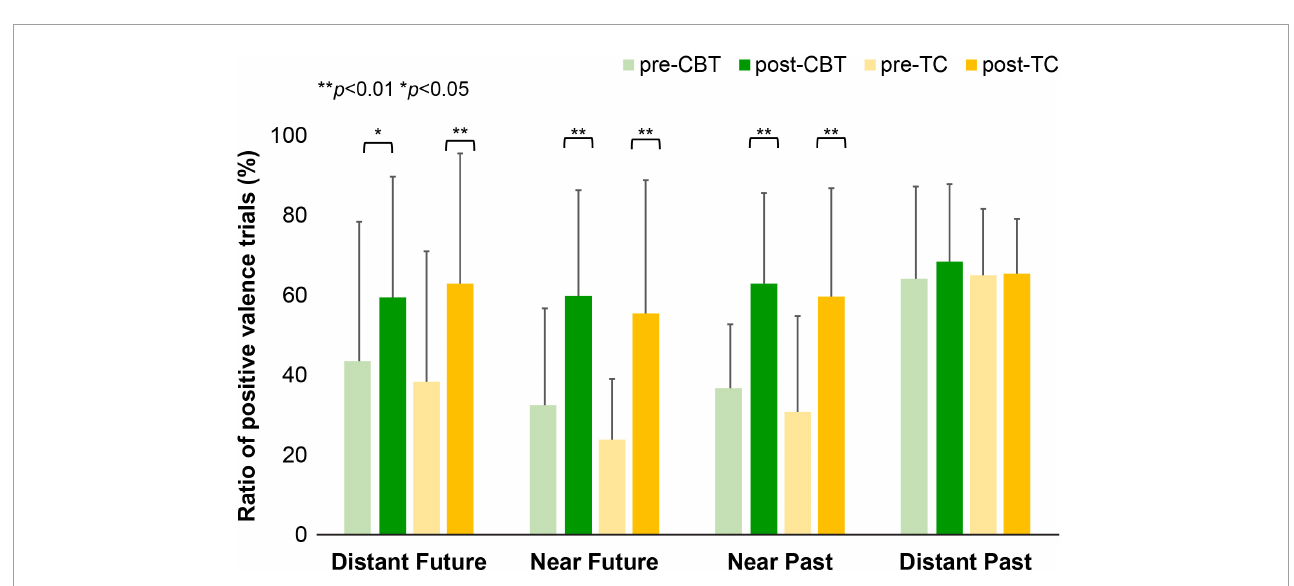
FIGURE4 The ratio of positive valence trial in the future thinking task. Mean ratio of positive valence across the four different conditions for the CBT group and TC group before and after treatment. A paired t -test shows that the ratio of positive valence responses increased after treatment in both groups in the distant future condition (CBT: p = 0.04; TC: p = 0.008), near future condition (CBT: p = 0.001; TC: p = 0.001), and near past condition (CBT: p = 0.005; TC: p = 0.002). CBT, cognitive behavioral therapy; TC, talking